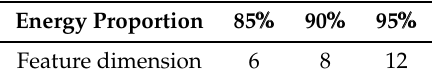
Table 1. Energy proportion of the feature dimensions after principal component analysis (PCA) dimensionality reduction.